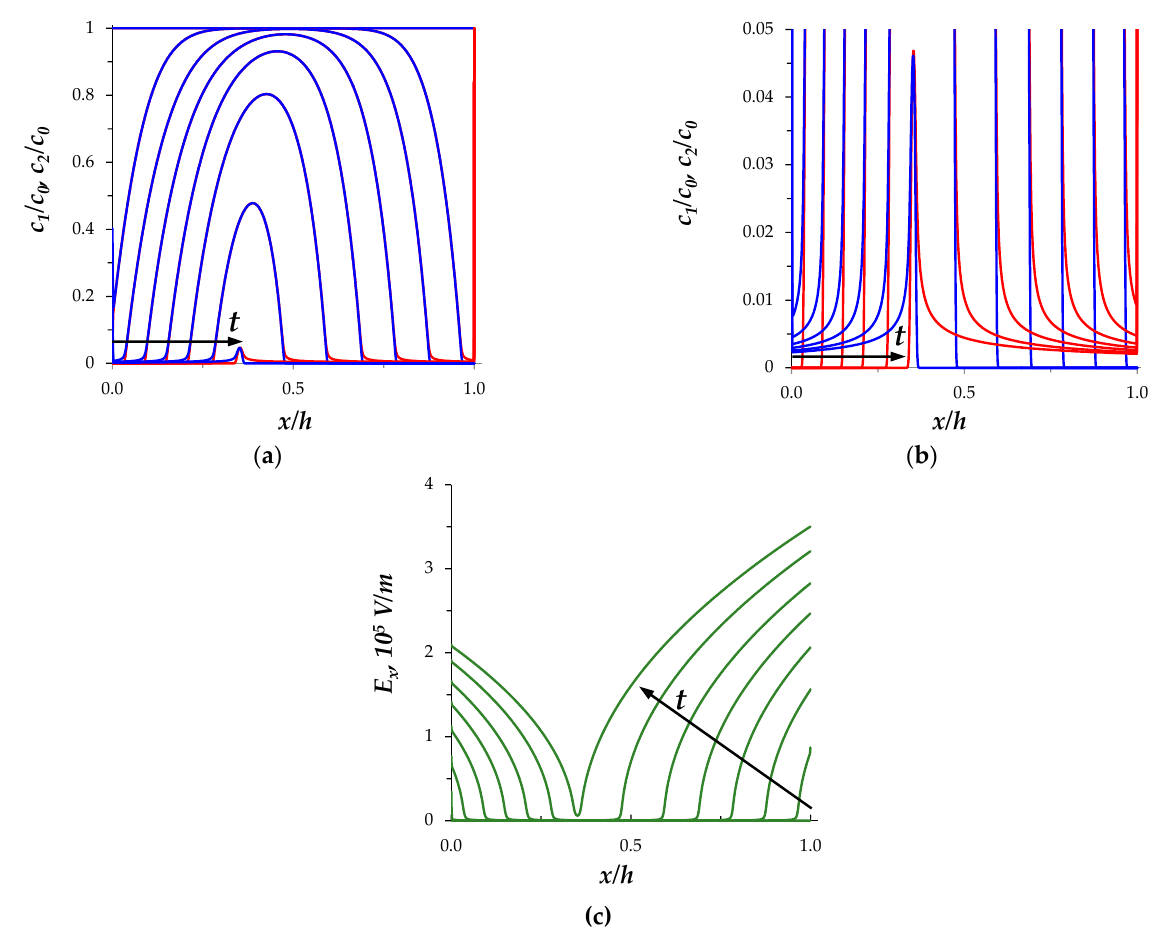
Figure 2. ( a ) Distributions of the normalized concentrations of cation, c 1 / c 0 , (red lines) and anion, c 1 / c 0 , (blue lines); ( b ) enlargement fragment of ( a ); ( c ) distribution of the electric field strength, E x . Calculation results at t = 0, 4, …, 24, 25.65 s for perfectly selective membranes T 2C = T 1A = 0, current density i = 2 i lim .